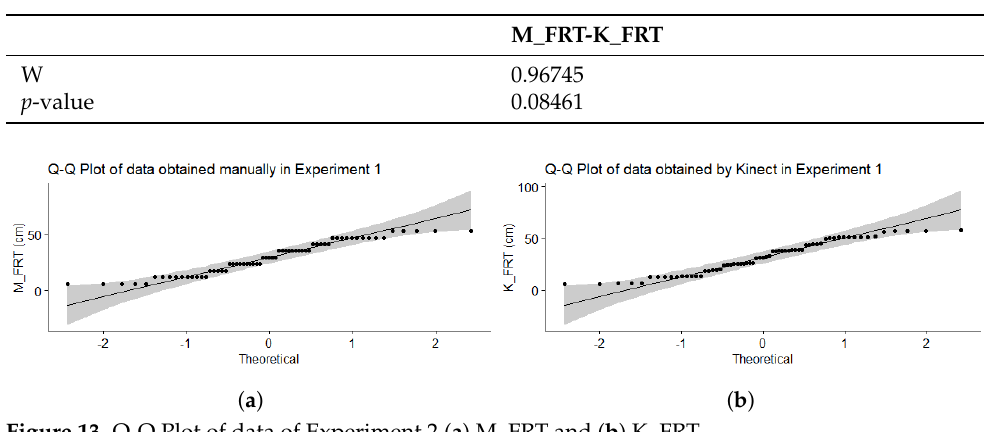
Table 5. Shapiro–Wilk normality test applied to data of Experiment 2.